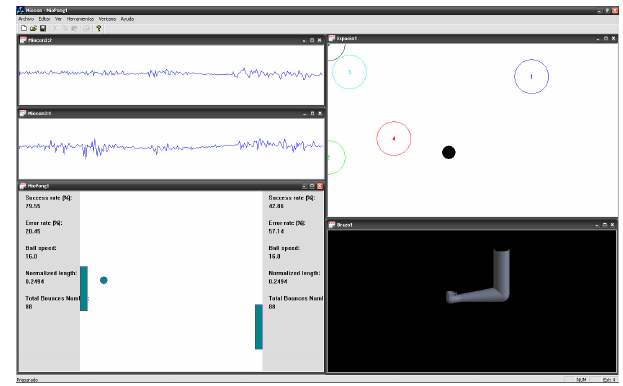
Figure 1. Tools in the UVa-NTS. Top left : signal viewer split in two graphs displaying the electromyography (EMG) signals from two muscles; top right : state navigator , where the rest point is the upper left corner and the pointer is centred due to the muscles effort; bottom right : virtual arm that moves when the state navigator pointer reaches a target; bottom left : Myo-Pong where the two paddles, due to the muscles’ activity, are displaced from the rest sites located at the top of each